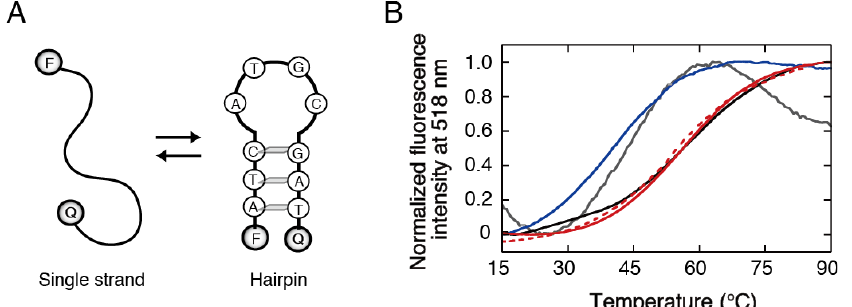
Figure 2. ( A ) Equilibrium for the hairpin formation of 10-mer HP by a single strand bearing a fluorophore, F, and a quencher, Q. ( B ) Melting curves of 10-mer HP in the solution (black), the solution containing unpolymerized acrylamide and bisacrylamide at 10% (blue), and unwashed and washed polyacrylamide gels at 10% (gray and red, respectively). The dotted line represents the annealing curve in the washed gel.